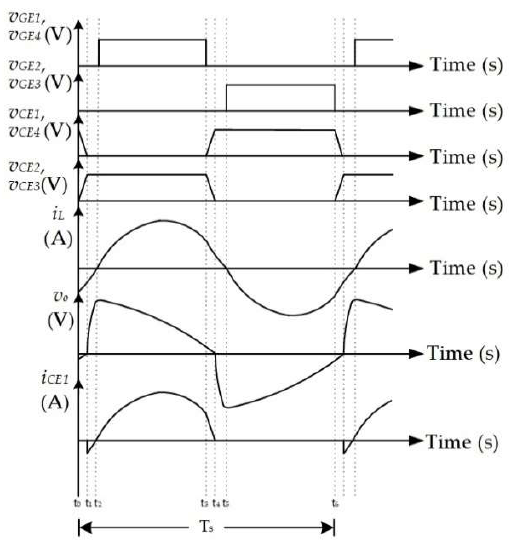
Figure 7. Fundamental waveforms of the full-bridge LC series resonant converter.